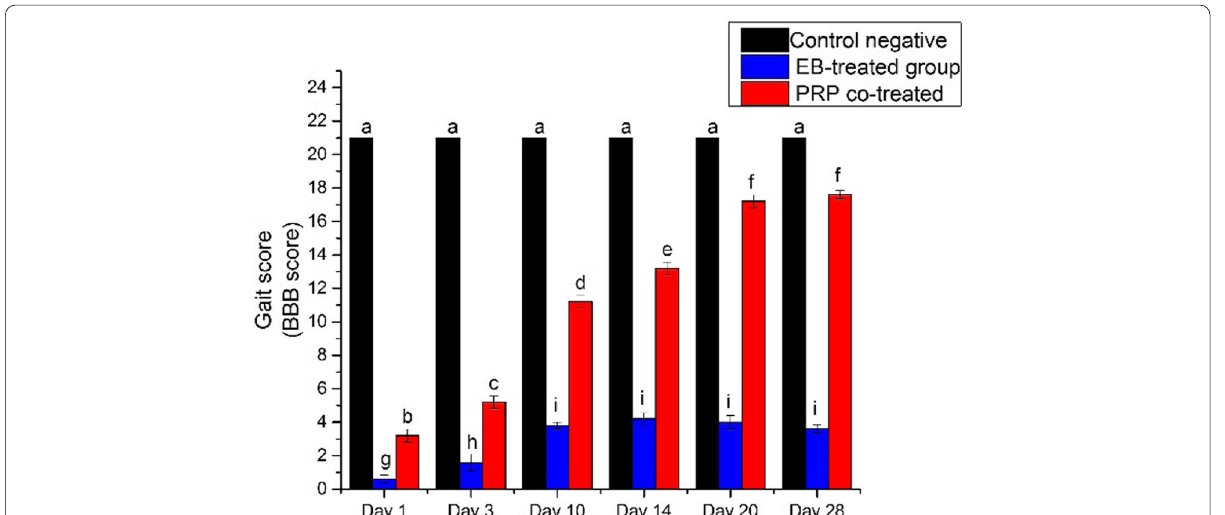
Fig. 4 Gait score (BBB score) during the study. The gait score of the cats of the PRP co-treated group was significantly increased over time (red column) except between days 20 and 28 where P 0.05. The gait score of the control negative group (black column) showed no significant ≤ differences all over the experiment, and the EB-treated group (blue column) showed significant differences between days 1 and 3 but no significant difference after. The columns of the same letter have no significance difference in between (for the interpretation of the references to color in this figure legend, the reader is referred to the web version of this article)